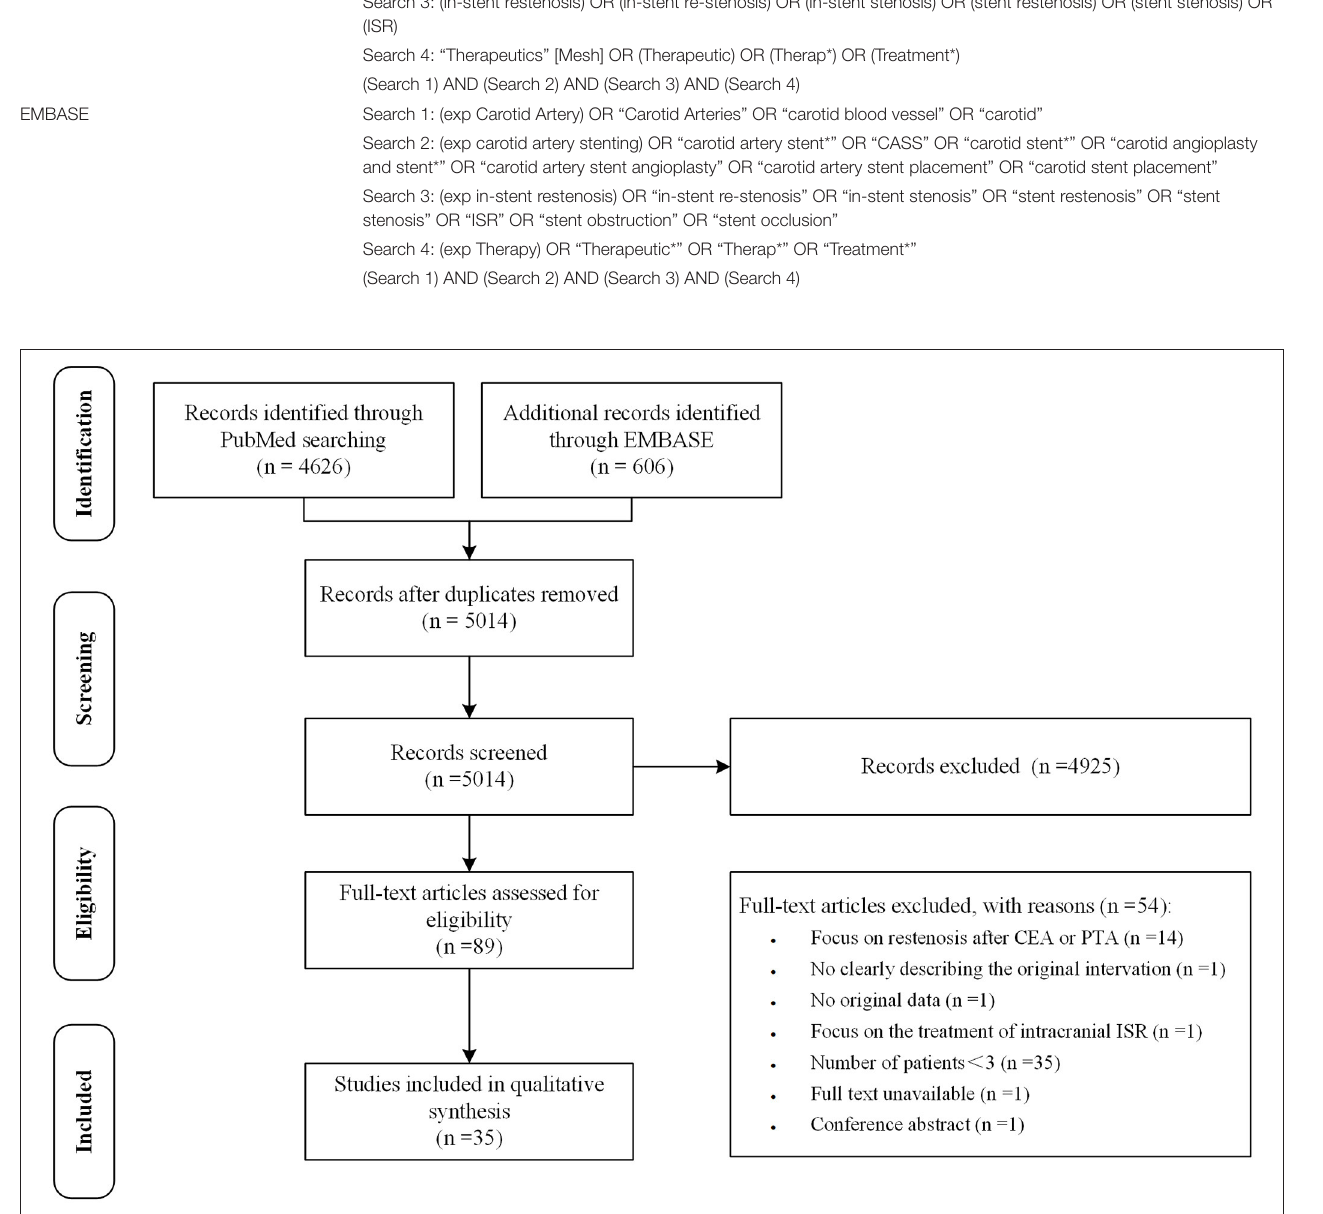
studies, and ISR was defined as > 70% or 80% in most studies;